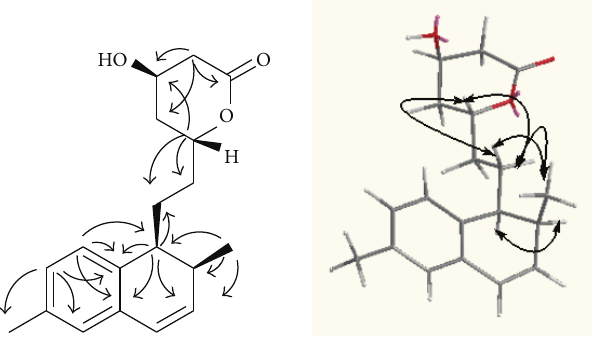
Figure 2: Key HMBC ( → ), and NOESY ( ↔ ) correlations in compound 1 .